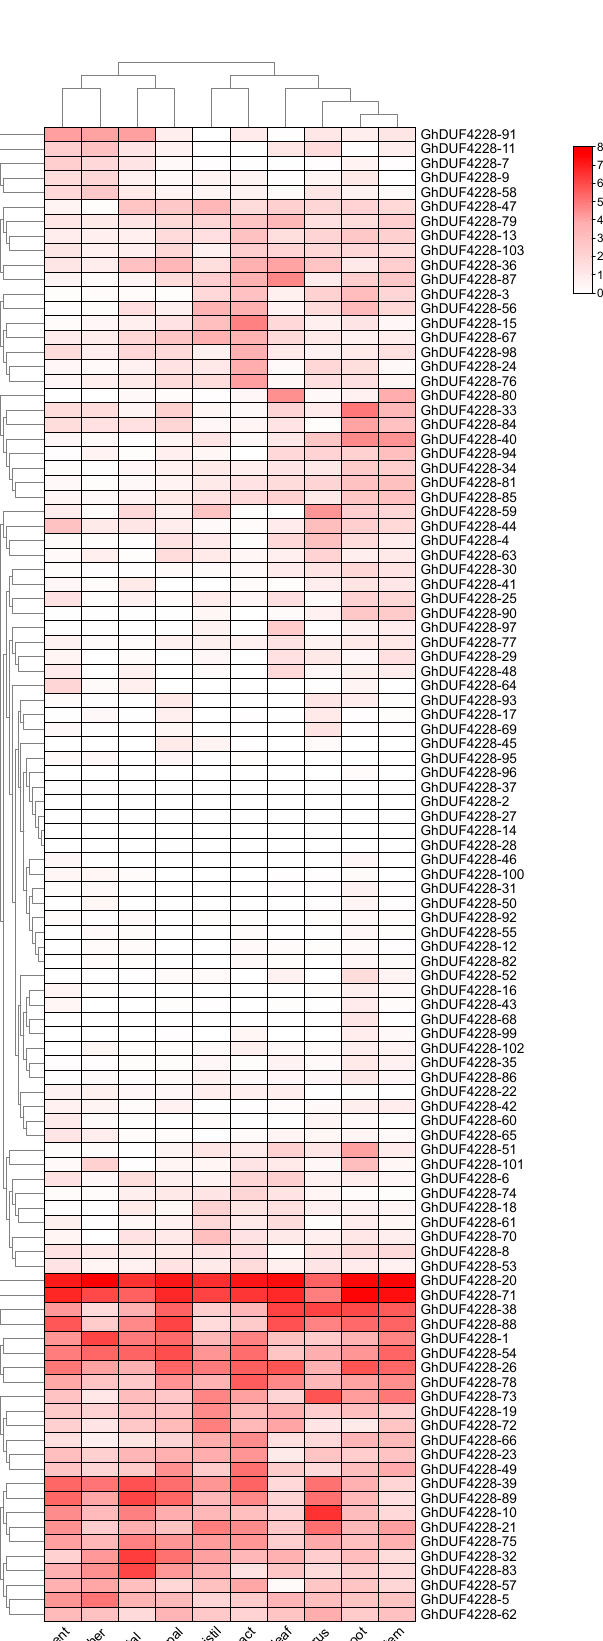
Figure 5. Expression profiles of GhDUF4228 genes in different tissues of Gossypium hirsutum . The color scale in the upper right corner is the FPKM value, normalized by log 2 (FPKM +